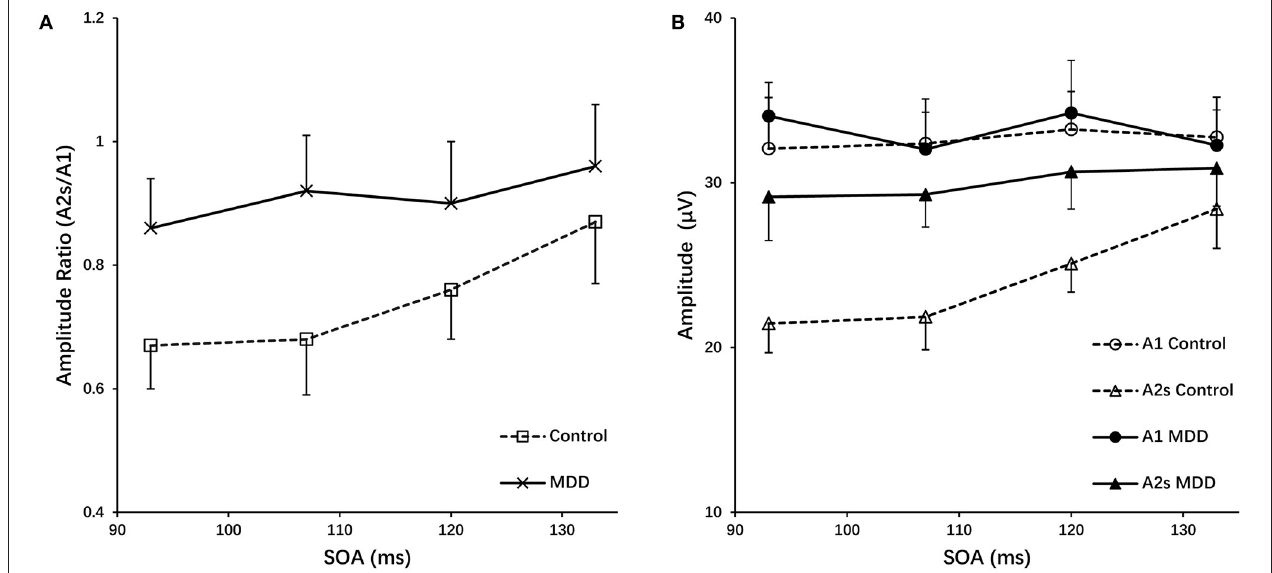
FIGURE 2 | (A) Amplitude ratios (A2s/A1) of the MDD and control group as a function of SOAs. (B) The first amplitudes (A1) and the second amplitudes after subtracting the response of a single-pulse (A2s) for the MDD and control group vs. SOA, grand mean ±